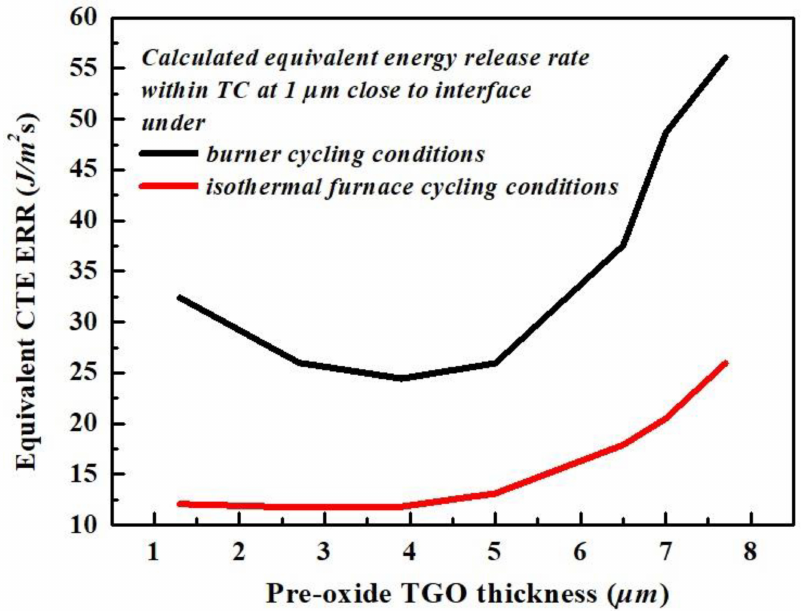
Figure 7. The calculated equivalent CTE ERR vs. the pre-oxide TGO thickness under isothermal furnace cycling condition and burner cycling